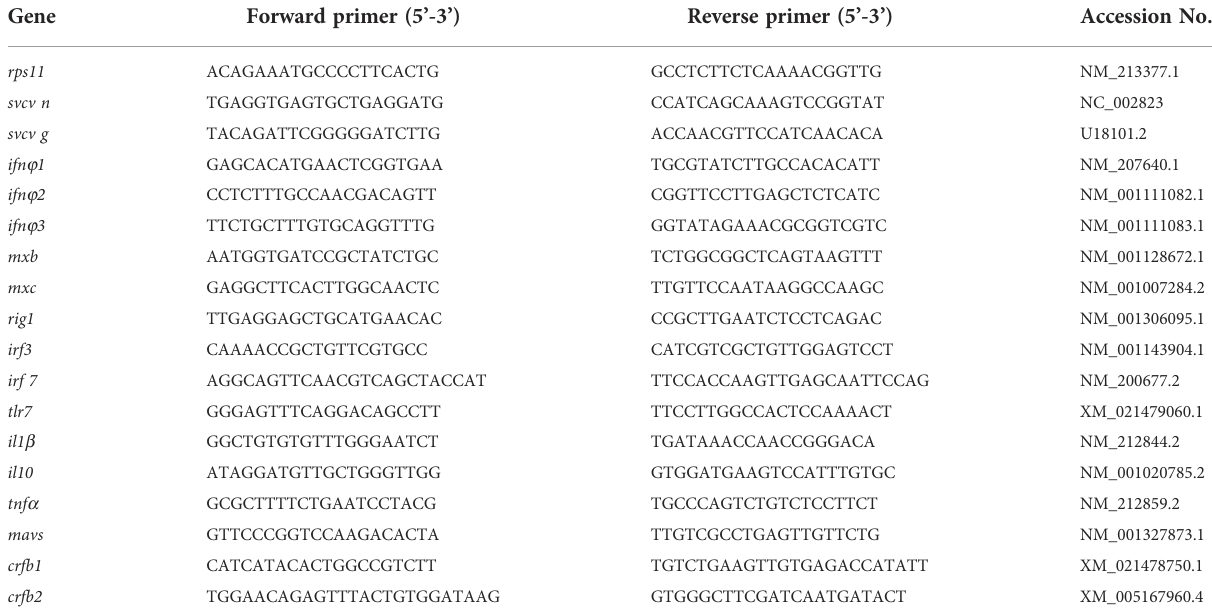
TABLE 2 Primer sequences for q RT-PCR